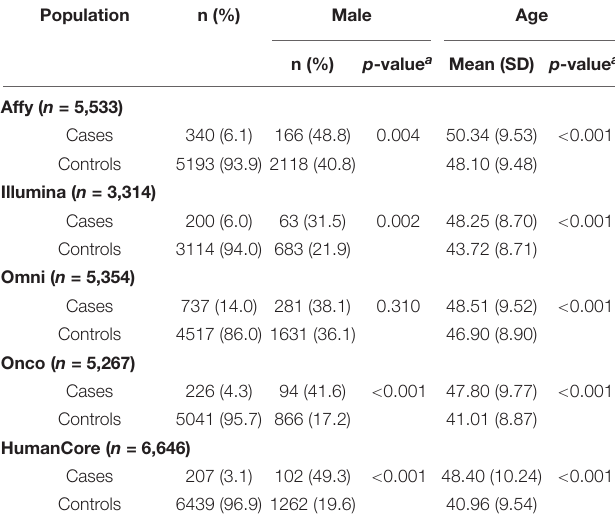
TABLE 1 | Study population characteristics and number of regions tested in each population.